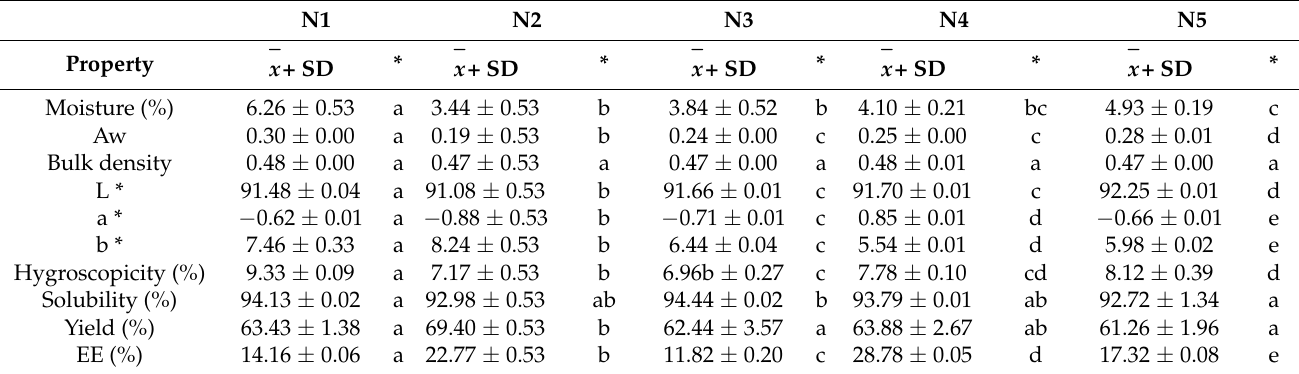
Table 2. Physical and chemical properties of